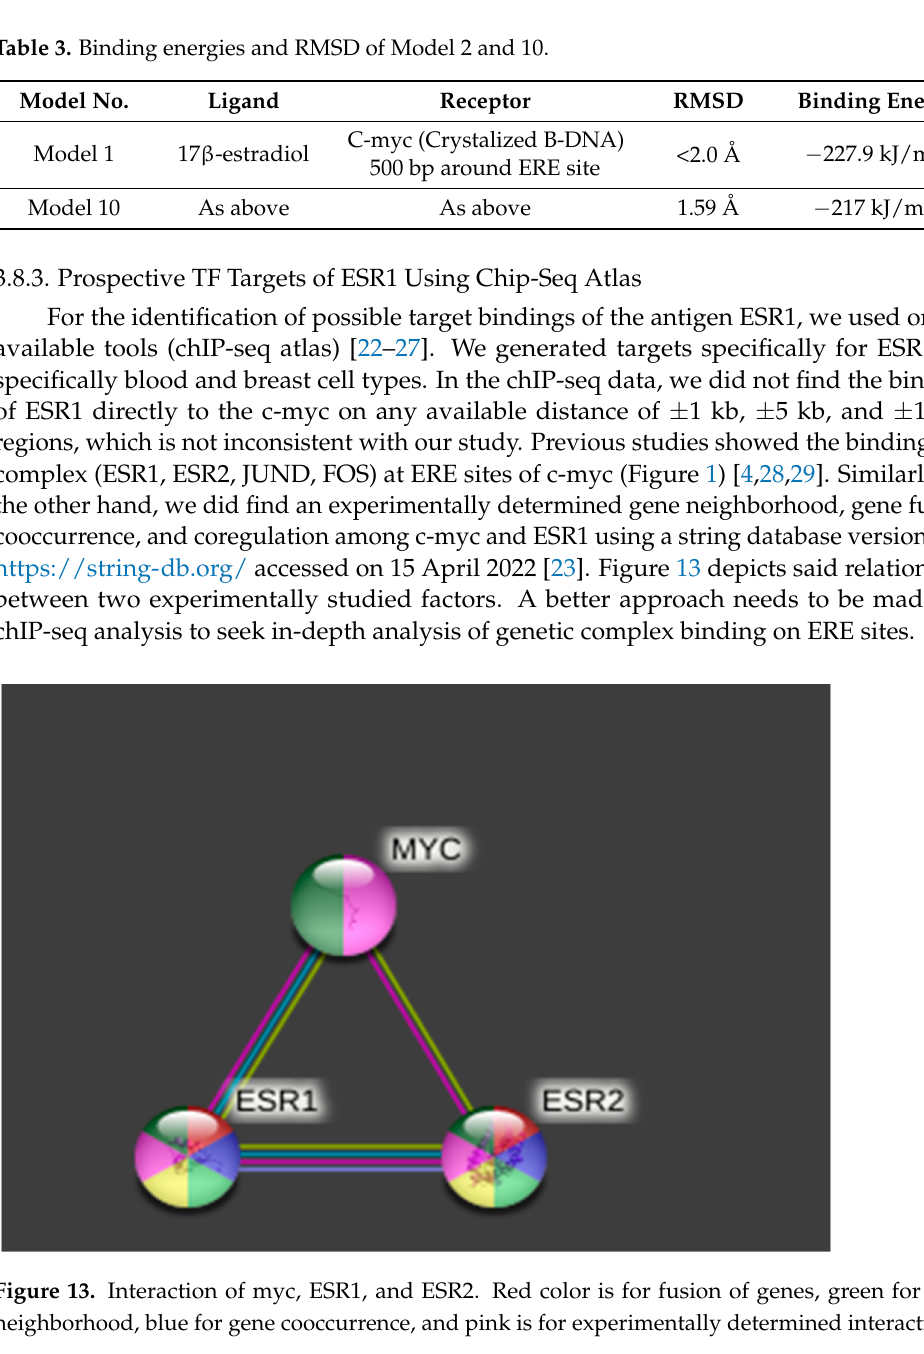
Figure 13. Interaction of myc, ESR1, and ESR2. Red color is for fusion of genes, green for gene neighborhood, blue for gene cooccurrence, and pink is for experimentally determined interactions.